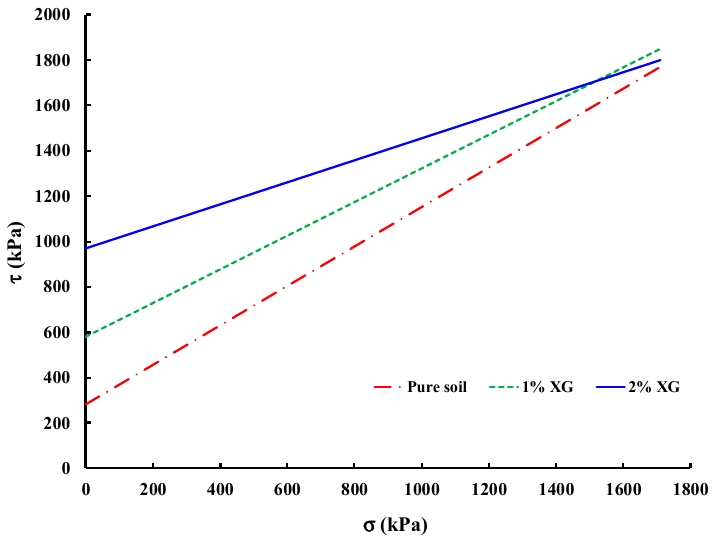
Figure 8. Results of UU triaxial tests; failure envelope curves. Table 3. Results of UU triaxial tests; internal friction angle and cohesion of pure soil and XG-treated soil. Soil Reference Cohesion, c